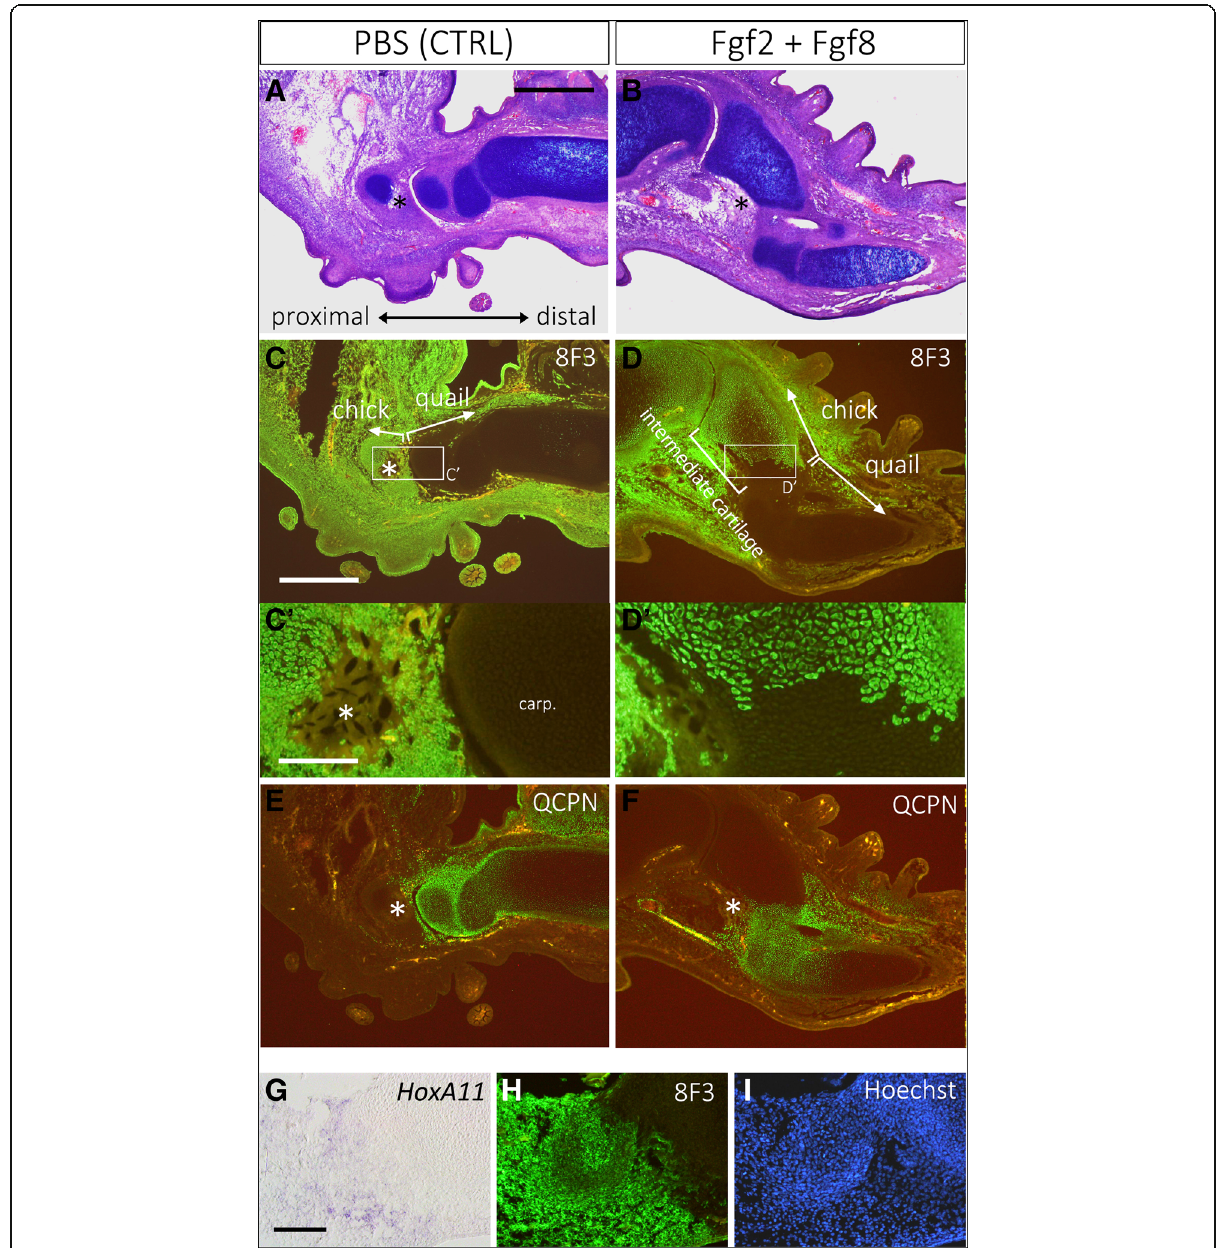
Fig. 7 Cellular contribution of the intercalary induced cartilage in chick limb buds. The grafted hand part was derived from a quail limb bud. a , c , e The control sample. b , d , f Fgf2+Fgf8 bead-grafted limb. a , b Histological observation. ( c – f ) Immunofluorescent analysis using the antibody specific for chick cells (8F3; c , d ) and for quail cells (QCPN; e , f ). C ’ and D ’ are the higher magnification views of the boxed regions in c and d , respectively. Asterisks indicate the beads. Carp. = carpal cartilage. (G – I) The relationship between the HoxA11 expression domain and the 8F3 expression domain was investigated in the adjacent sections. g HoxA11 expression. h 8F3 antigen expression on the adjacent section. I is Hoechst staining for nuclei and is the identical section to H. The scale bars in A, C, C ’ , and G are 500, 500, 100, and 100 μ m,